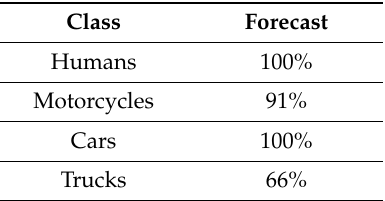
Table 8. Cases 1, 3, and then 5 prediction accuracy.